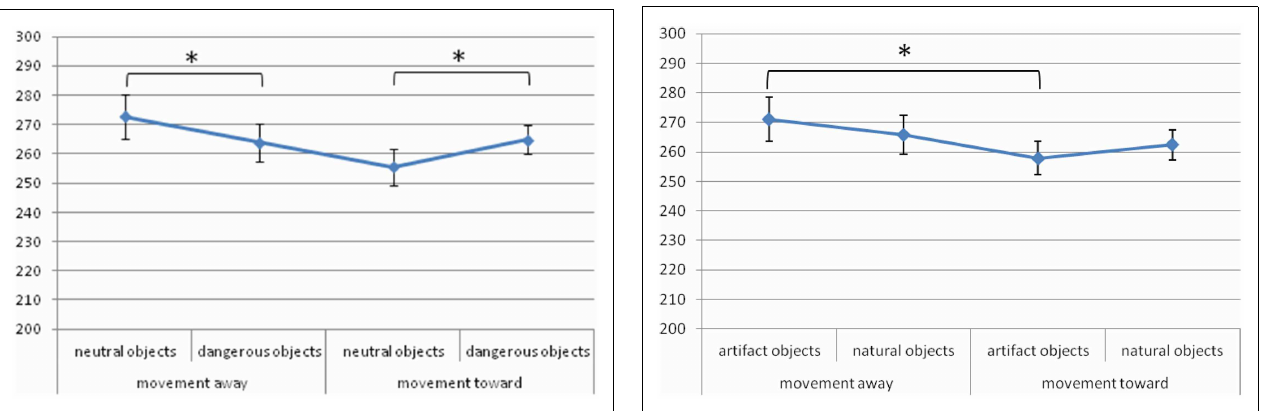
FIGURE 1 | Significant Object Dangerousness × Object Movement Direction interaction for RTs in Experiment 1, values are in milliseconds and bars are SEM .